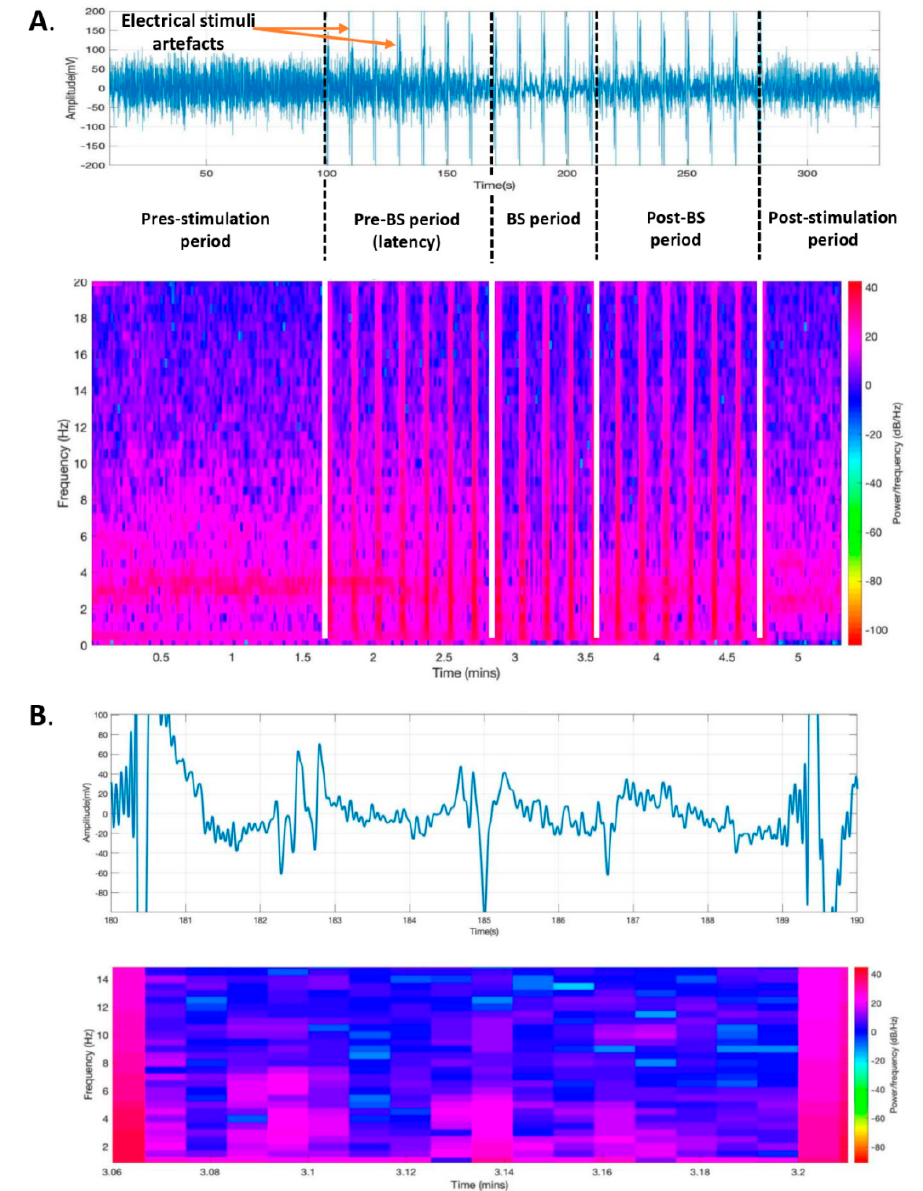
Figure 4. Electrocorticogram changes during claustrum stimulation. ( A ) Frontal left electrocorticogram with its corresponding spectrogram during the prestimulation, stimulation (with pre-BS, BS, and post-BS phases), and poststimulation periods. ( B ) A detailed view of the spectrogram on an 8-second electrocorticogram recording during the BS period between two electrical stimuli. BS—burst suppression.